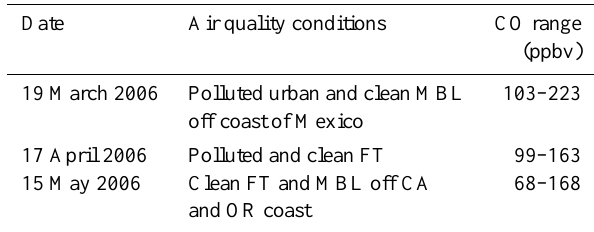
Table 1. Chemical Conditions for Intercomparison